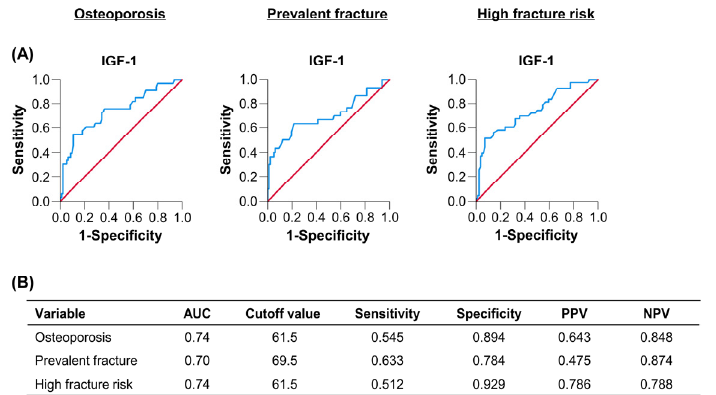
Figure 5. ( A ) The receiver operating characteristic curve analysis of serum insulin-like growth factor 1 (IGF-1) for predicting osteoporosis, prevalent fracture and high fracture risk. ( B ) The cutoff values of IGF-1 for predicting these events were 61.5 ng/mL for osteoporosis, 69.5 ng/mL for prevalent fracture and 61.5 ng/mL for high fracture risk. AUC, area under the curve; NPV, negative predictive value; and PPV, positive predictive value.